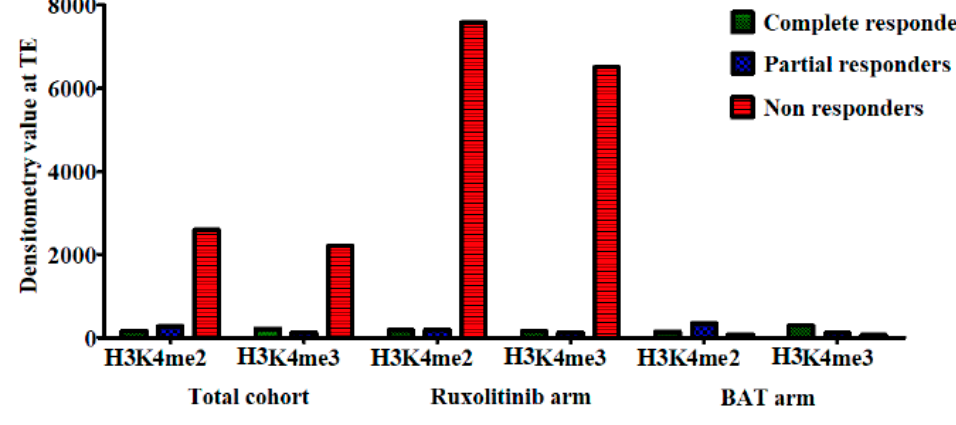
Figure 6. H3K4 levels at trial entry correlate with response.